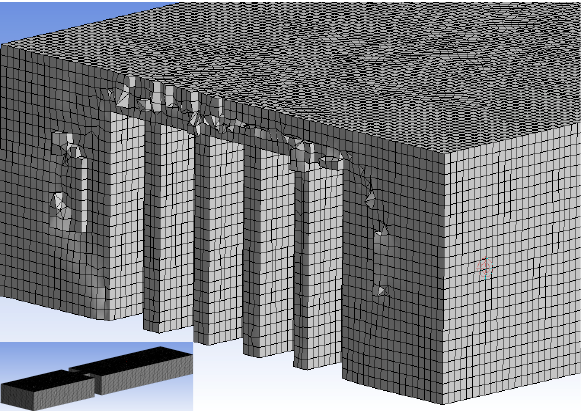
Fig. 5. Structured hexahedral